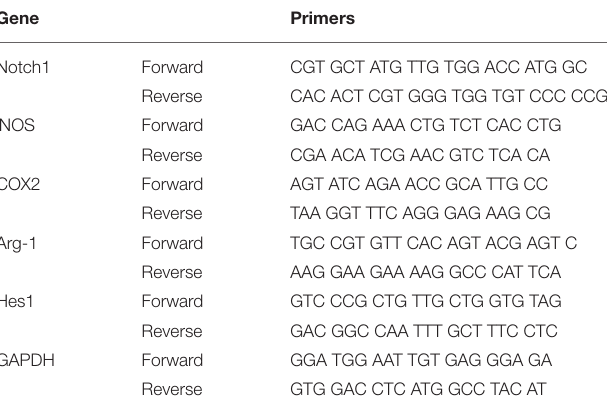
TABLE 1 | Primers used for